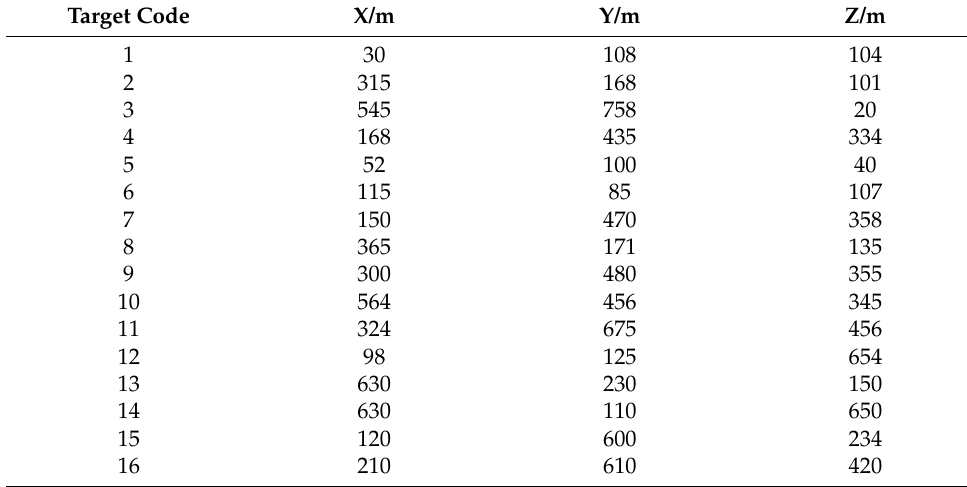
Table 7. Obstacle center coordinates.